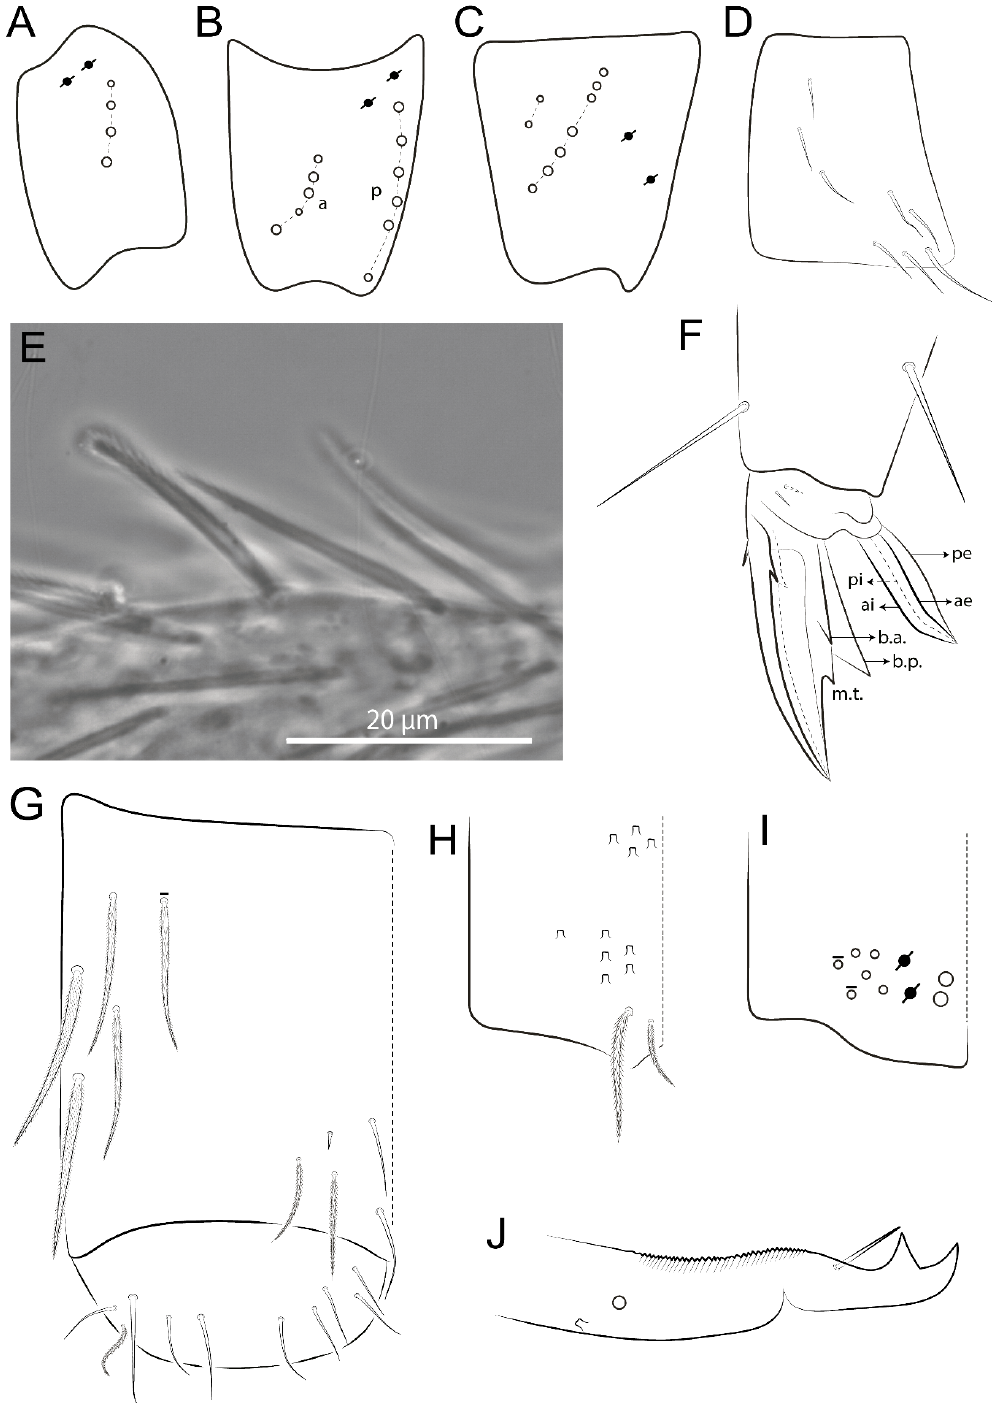
Figure 60. Pseudosinella pusilla sp. nov. ( A–C ) subcoxa I–III, respectively; ( D ) trochanteral organ; ( E ) modified chaeta of tibiotarsus; ( F ) distal tibiotarsus and empodial complex III (anterior view); ( G ) collophore (lateral view); ( H ) distal part of manubrium (ventral view); ( I ) manubrial plate (dorsal view); ( J ) distal dens and mucro (outer view).